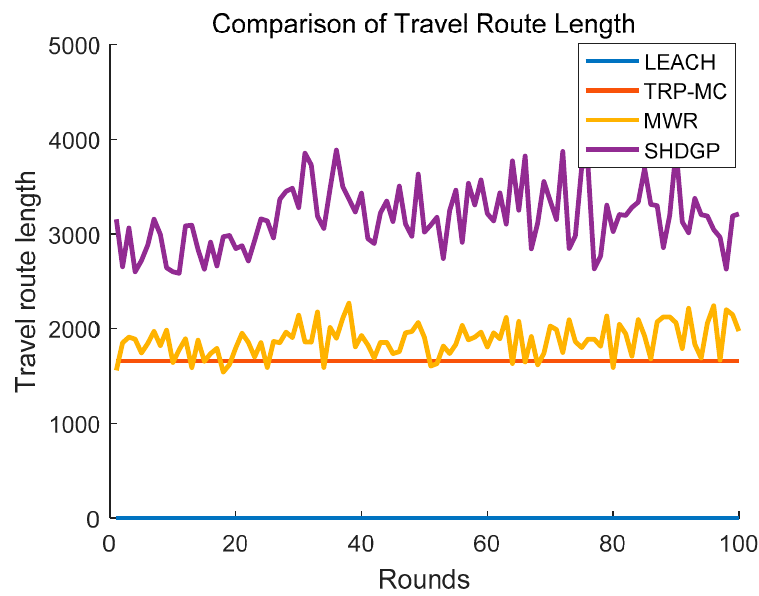
Figure 12. Comparison of travel route length between different algorithms.